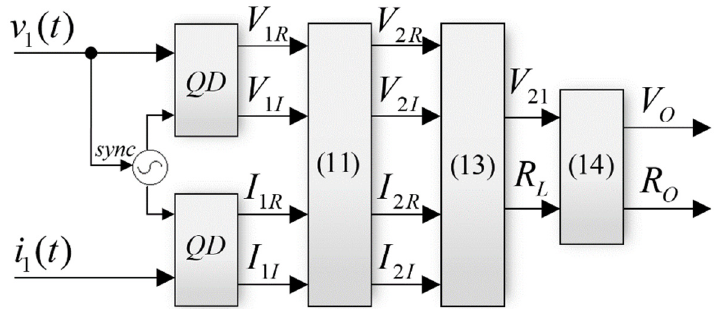
Figure 4. Flow diagram of the QD-based output variables calculation process.